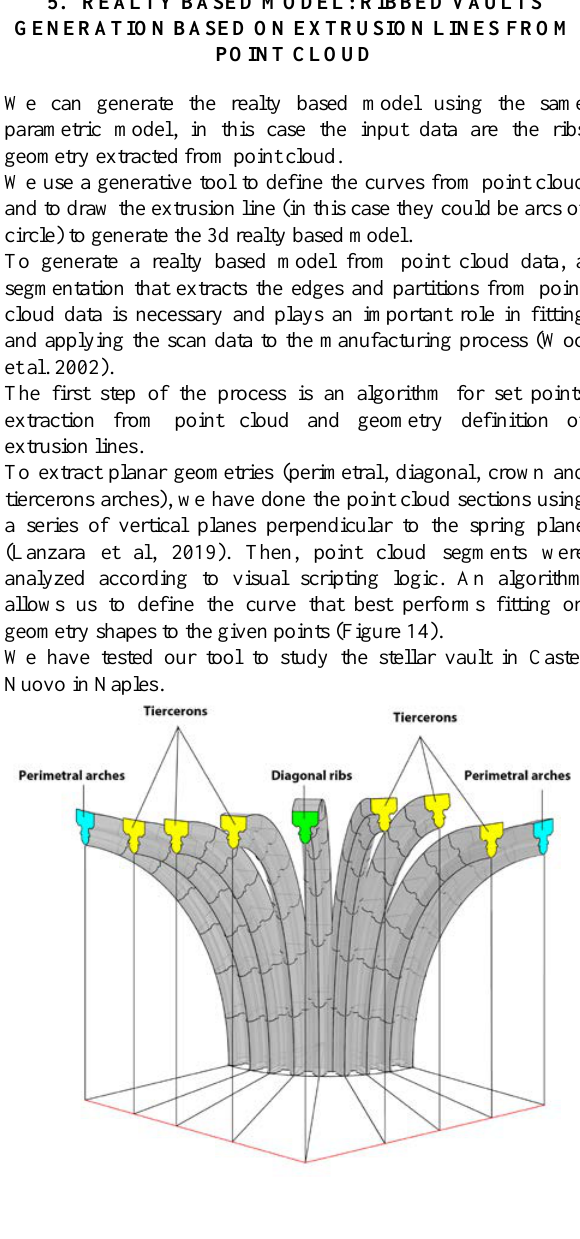
Figure 10 . Parametric model for ribs and arches profile based on treatises drawings.